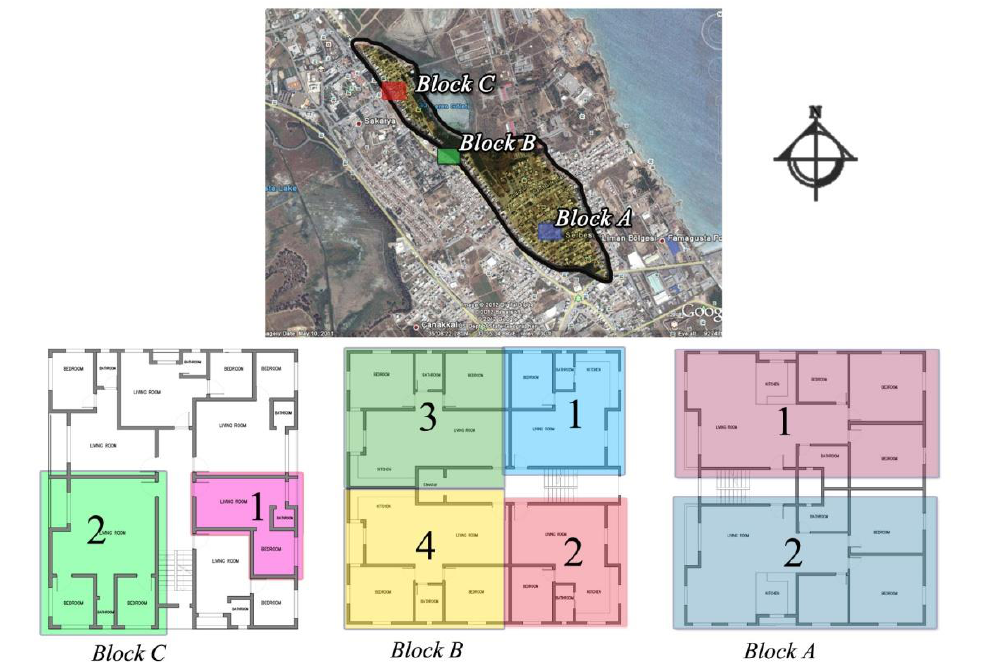
Figure 2. Position of three residential apartment in Karakol area for surveying (Retrieved from URL 2, 13 th march, 2016), and also plans of three sample apartments; from left to right. Uzun apartment Merkez, Uzun apartment 10, Muçize apartment (drawn by author).